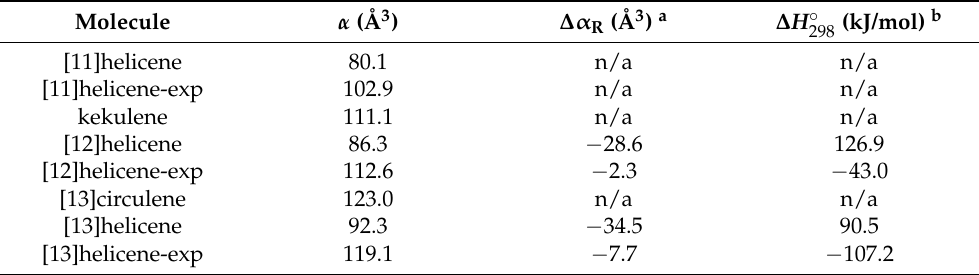
Table 1. The calculated thermochemical parameters and mean polarizabilities of the studied PAHs.